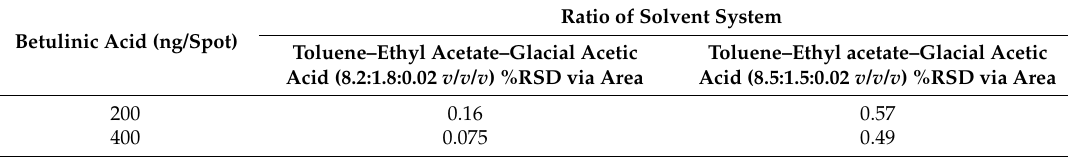
Table 4. Robustness of Method ( n =